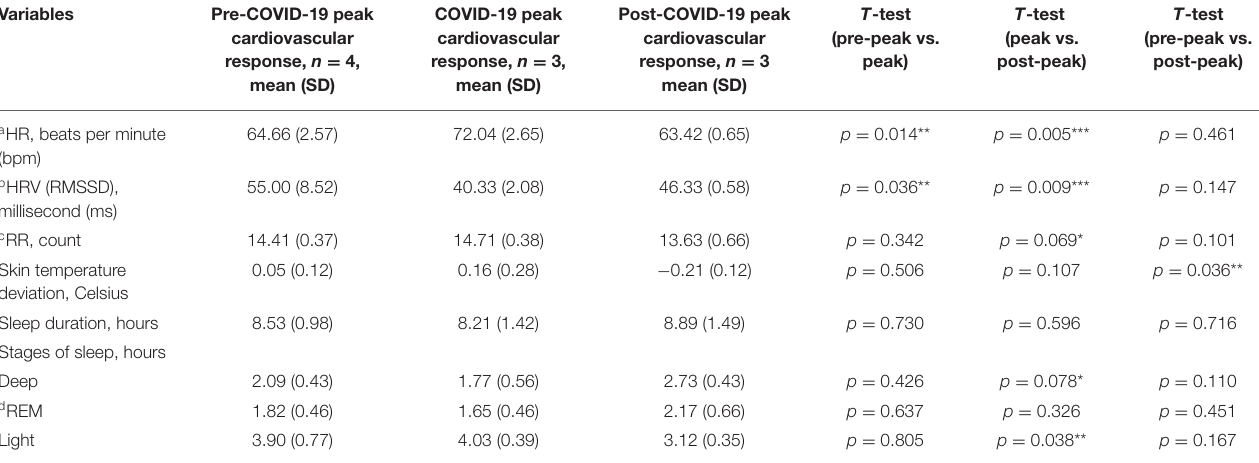
TABLE 1 | Case I: comparison of physiological responses to COVID-19 surrounding the period of infection.